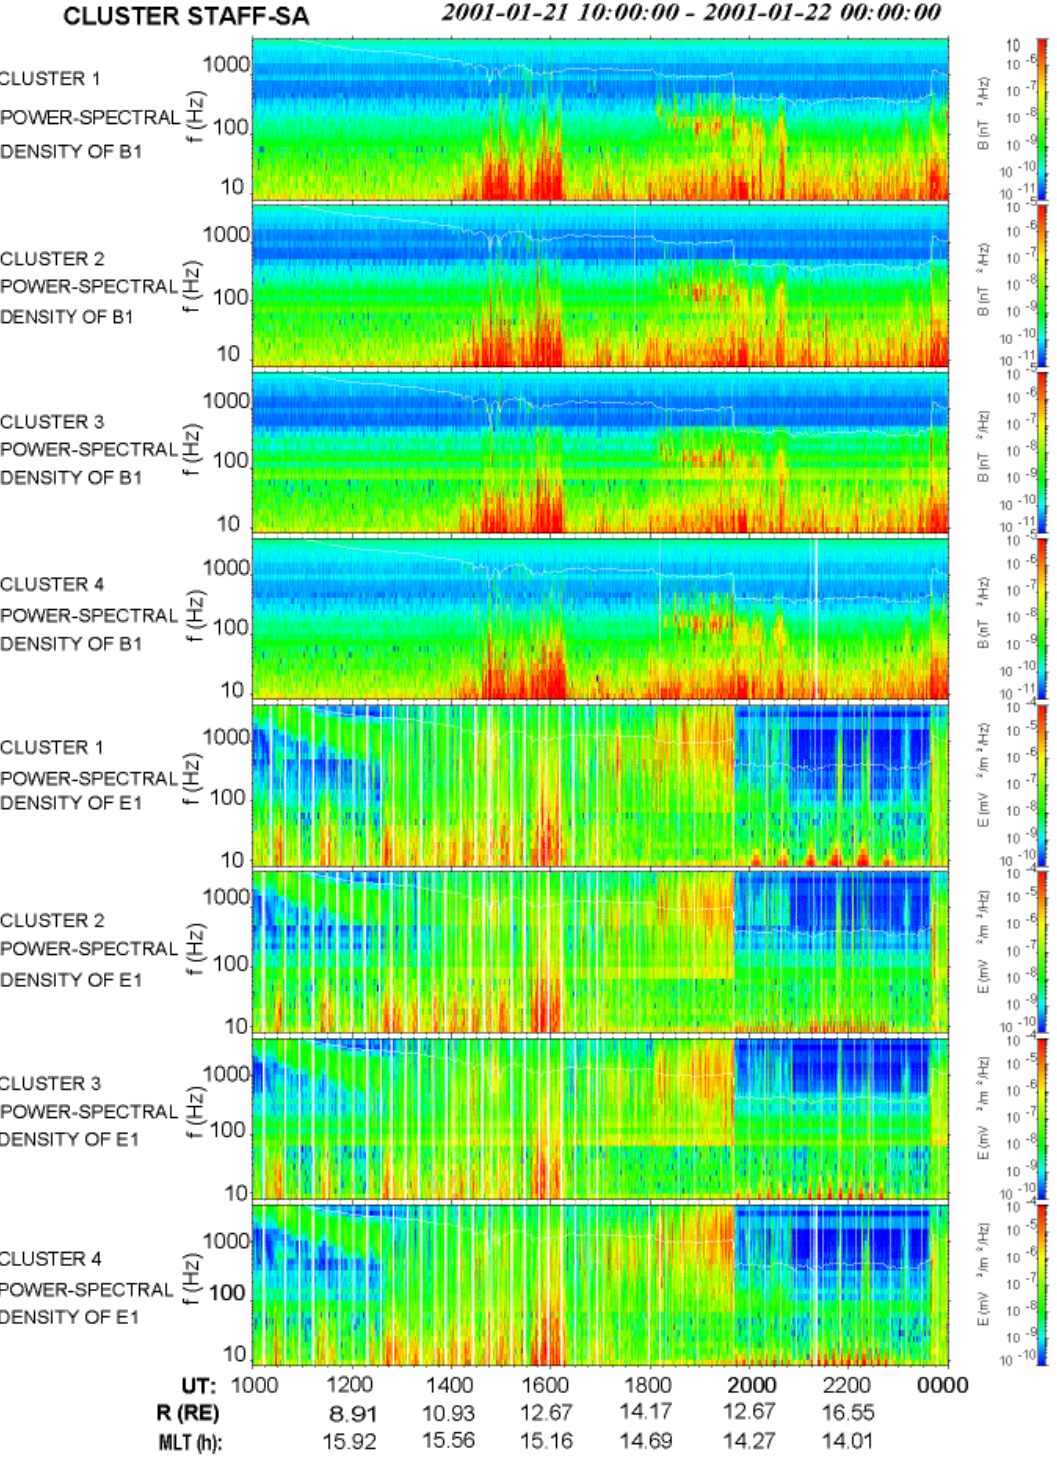
Fig. 5a. Overview of dynamic spectra from the Spectrum Analyser data (10Hz–4kHz) for 14h of data on 21 January 2001. The white line superimposed on the dynamic spectra is the electron gyrofrequency computed from the FGM data. Between 14:00 and 16:00UT Cluster probably first crosses the cusp, then the magnetopause, and stays in the magnetosheath until the bow shock is crossed at 19:40UT, Cluster then being in the Solar Wind until